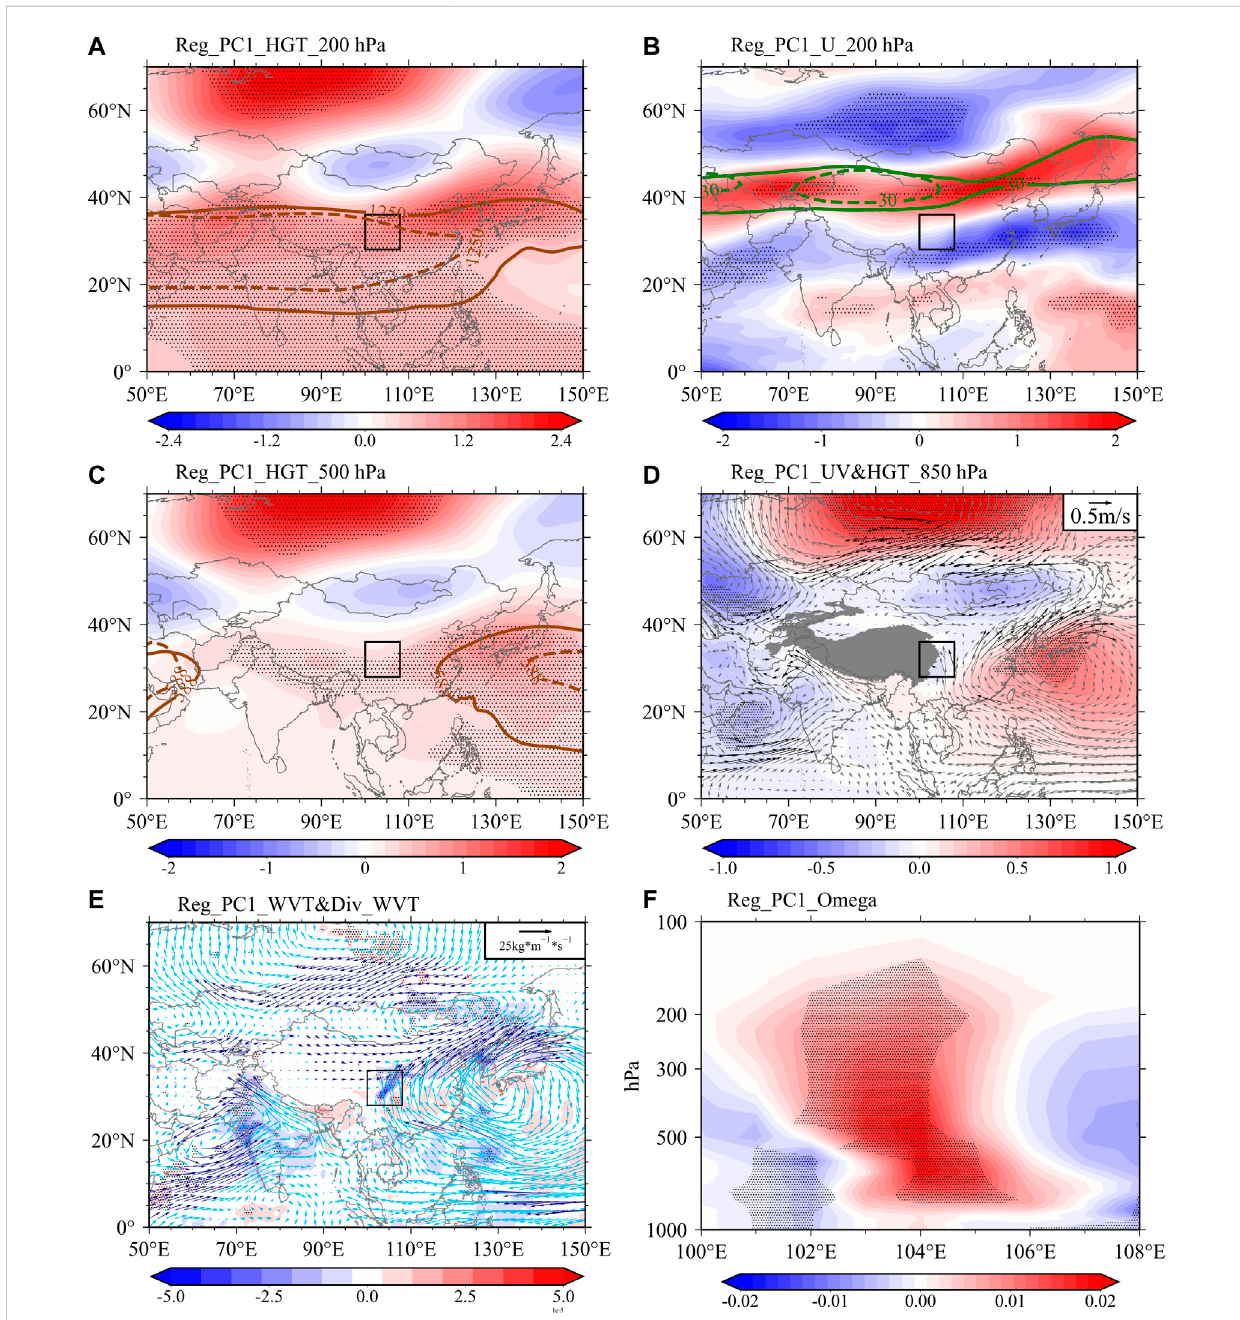
FIGURE 5 Regressed (A) geopotential height at 200 hPa (Shading, Unit: gpm; the dashed and solid brown lines represent the 12,500 gpm isoline in the climatological and regressed mean, respectively), (B) the zonal wind at 200 hPa (Shading, Unit: m · s − 1 ; the dashed and solid green lines represent the 30 ms − 1 isolinesintheclimatologicalandregressedmean,respectively), (C) thegeopotential heightat500 hPa (Shading,Unit:gpm; thedashedandsolid brown lines are the same as (A) but for 5,880 isolines). (D) The geopotential height at 850 hPa (Shading, Unit: gpm) and wind fi elds (Vectors, Unit: m · s − 1 ). (E) The WVT (Vectors, Unit: kg · m − 1 · s − 1 ) and its divergence (Shading, Unit: kg · m − 2 · s − 1 ), and (F) the height-longitude pro fi le of vertical velocity along the latitudes 30 ° – 36 ° N (Shading, Unit: 10 − 1 Pa · s − 1 ) in late summer onto the interannual component of PC1 from 1961 to 2021, respectively. Dotted areas are statistically signi fi cant at the 95% con fi dence